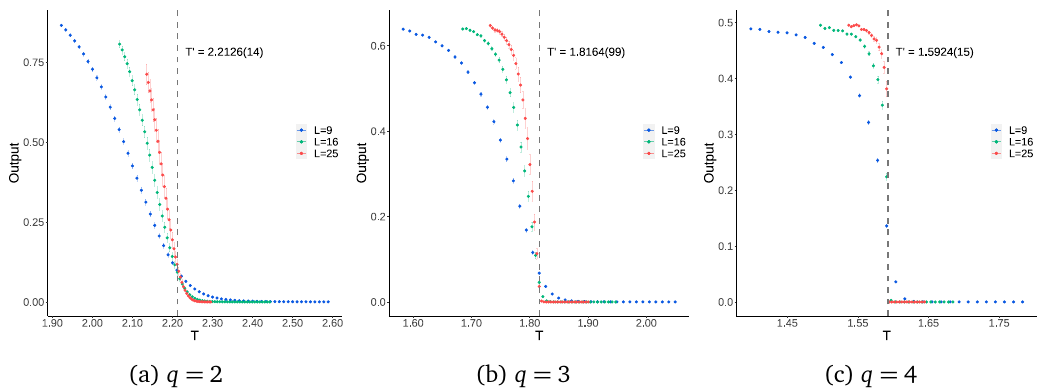
Figure 10: The relationship between temperature and the average output of an en- semble of 10 independently trained ANNs – training with MC data of the ferromag- netic square-lattice Ising model, and testing with MC data of the ferromagnetic q - state Potts model on a cubic lattice. The error bars shown are 99.7% confidence intervals of the ensemble average.